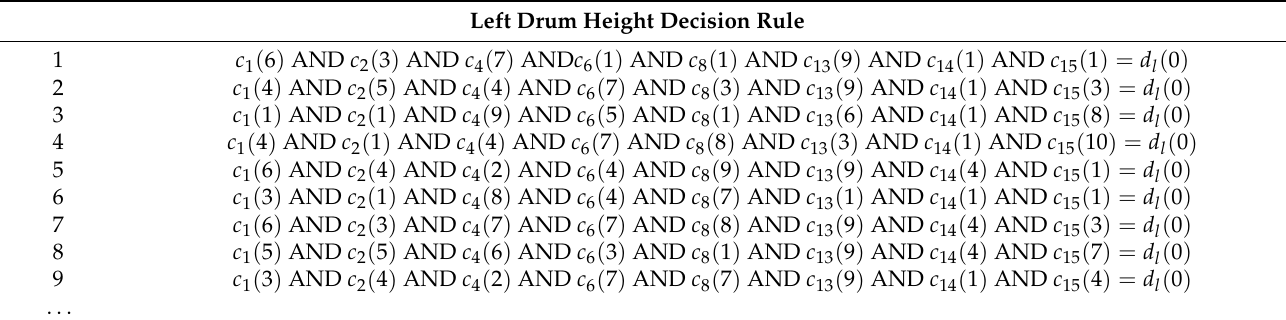
Table 7. Left drum height decision